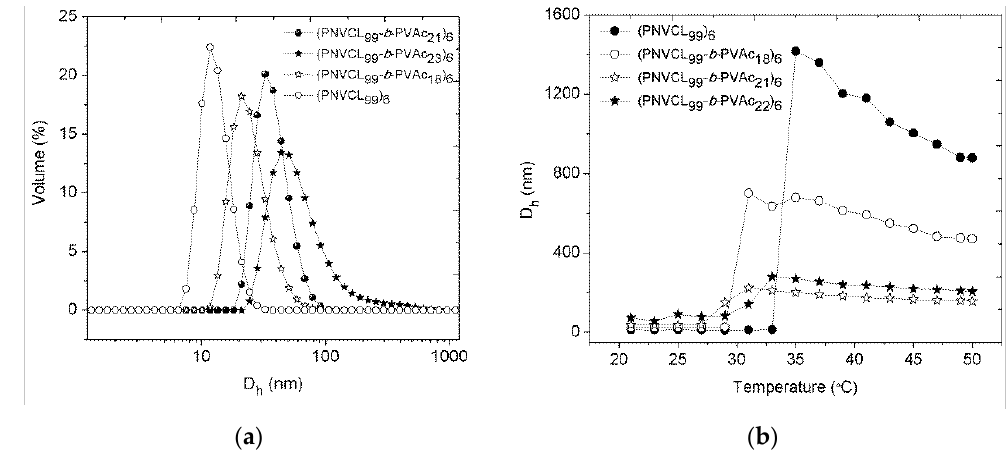
Figure 6. DLS measurements ( c = 1 mg/mL in water) for star (PNVCL- b -PVAc) 6 block copolymers: ( a ) D h of (PNVCL 99 ) 6 and the corresponding (PNVCL 99 - b -PVAc) 6 block copolymers, measured at 20 ◦ C; and ( b ) evolution of the D h of the (PNVCL 99 ) 6 and (PNVCL 99 - b -PVAc) 6 as a function of the temperature.